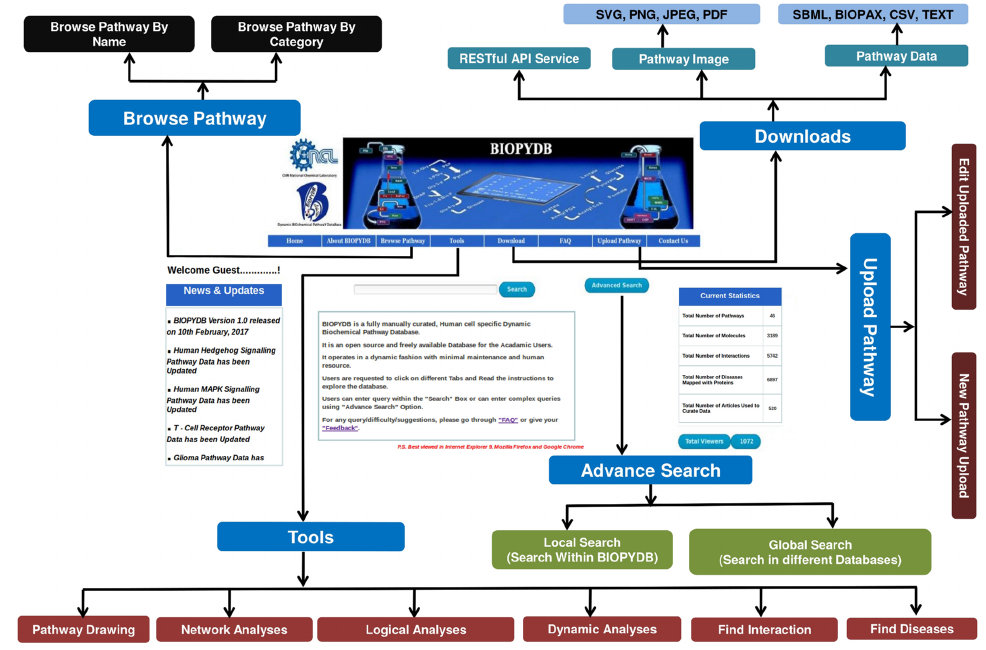
Figure 6: The web-interface of